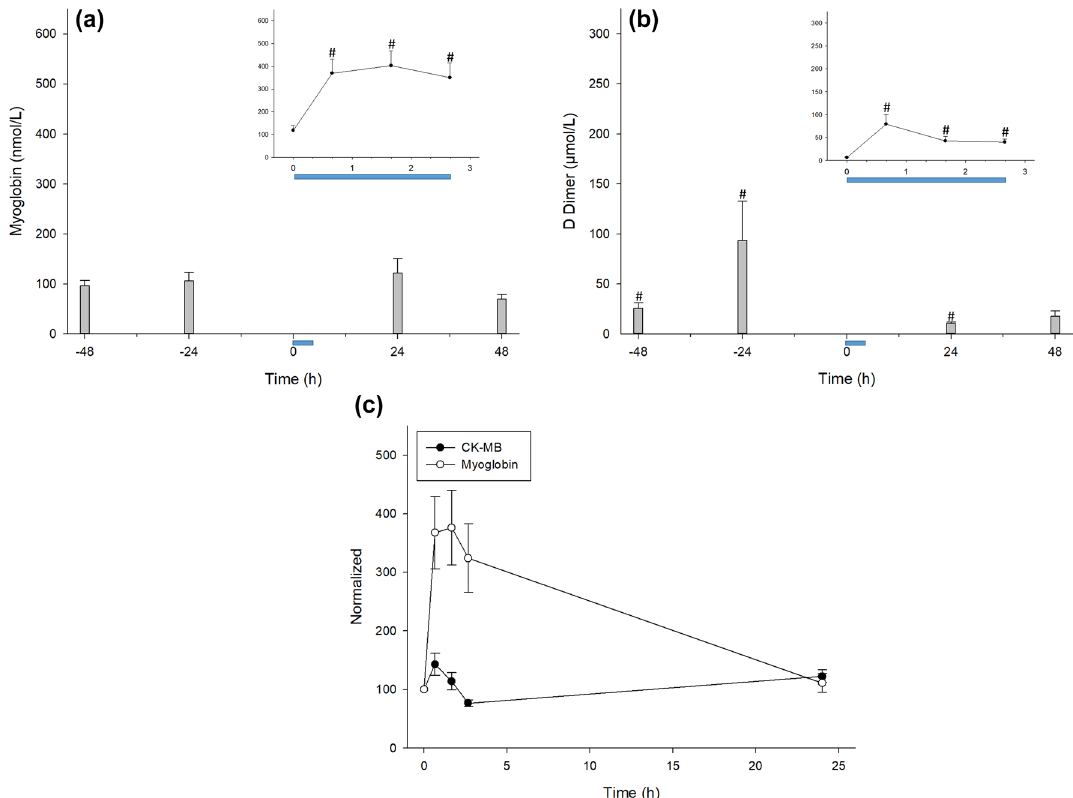
Figure 4. The microinjury muscle biomarkers myoglobin and CK-MB as D-dimer increased in response to the CCombat protocol. ( a ) Myoglobin #Pre vs . Post: p = .001; effect size = 1.1; statistical power = 0.98; #Pre vs . + 60 min: p < .001; effect size = 1.2; statistical power = 0.99; #Pre vs . + 120 min: p < .001; effect size = 1.0; statistical power = 0.96; ( b ) d-dimer #Pre vs . − 48 h: p < .001; effect size = 0.9; statistical power = 0.94; #Pre vs . − 24 h: p < .001; effect size = 0.5; statistical power = 0.54; #Pre vs. Post: p < .001; effect size = 0.8; statistical power = 0.89; #Pre vs . + 60 min: p = .002; effect size = 0.9; statistical power = 0.93; #Pre vs . + 120 min: p < .001; effect size = 1.3; statistical power = 0.99; #Pre vs . + 24 h: p = .010; effect size = 1.0; statistical power = 0.95 and ( c ) comparison of CK-MB and d-dimer concentrations up to 24 h after the protocol (Pre; Post; + 60 min; 120 min and + 24 h). The blue bar represents the CCombat protocol in scale in both graphs. AVG ±